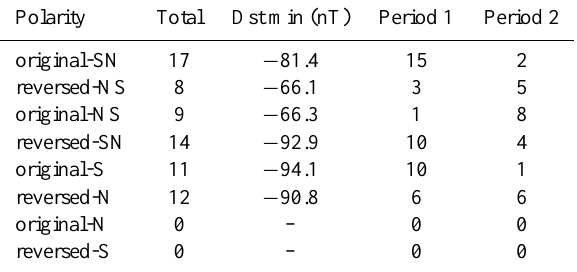
Table 5. The number of events when magnetic clouds of different B Z -types led to a Dst < − 50nT storm. The second column gives the total number of storms for Period 1 and Period 2 combined, and the next column the average Dst minimum. The last two columns give the number of storms during our two study periods